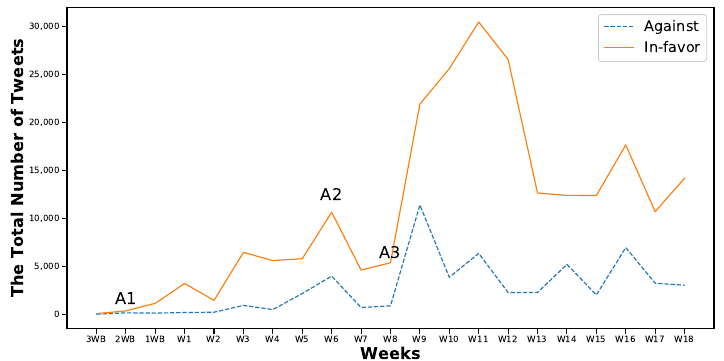
Figure 5. Cumulative weekly cleaned tweets for the first semester of the 2020 academic year.